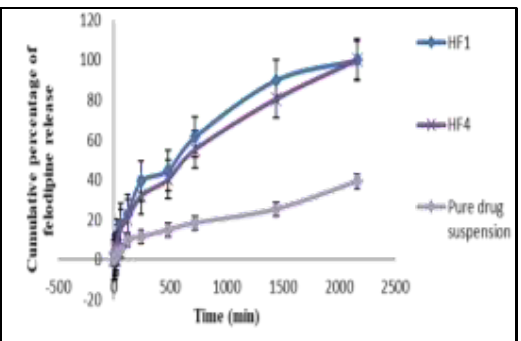
Figure 4. In vitro felodipine release profile from LPHNs formulations HF1,HF4 and the pure drug suspension at phosphate buffer pH 6.8 + 0.3 % polysorbate 80 solutions the values of mean ±SD (n=3).